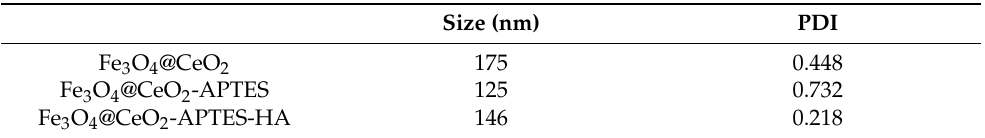
Table 1. Dynamic Light Scattering (DLS) analysis table for the average particle size determination and polydispersity index (PDI) of Fe 3 O 4 @CeO 2 , Fe 3 O 4 @CeO 2 -APTES and Fe 3 O 4 @CeO 2 -APTES-HA in dispersed forms.